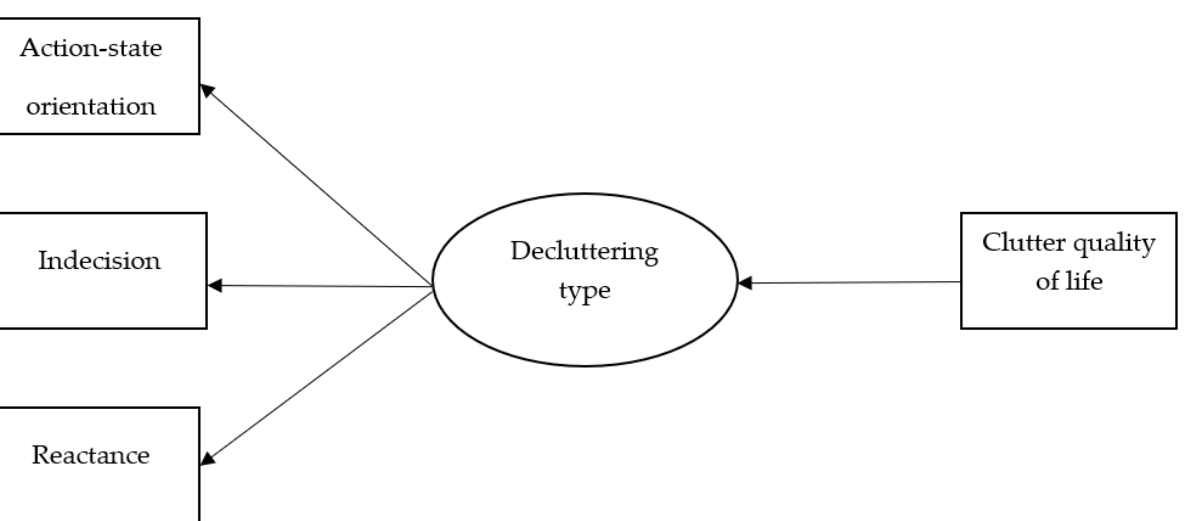
Table 3. Conditional probabilities and proportion estimates.